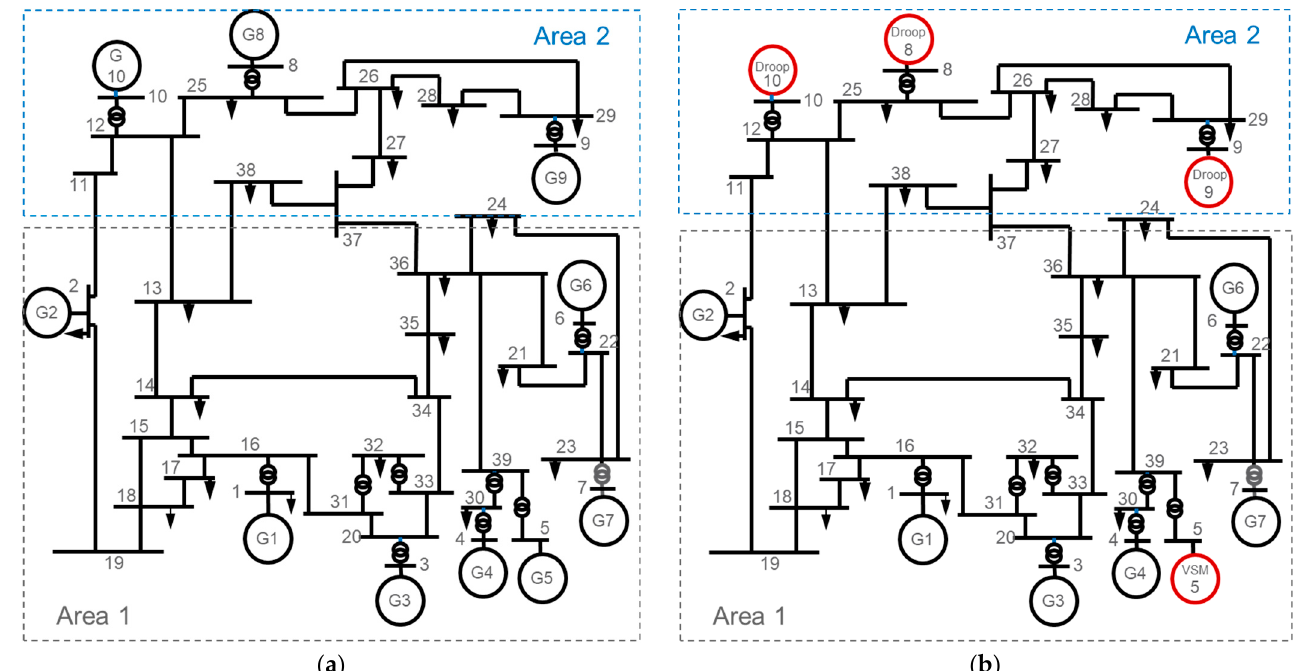
Figure 1. IEEE 39-bus New England test system. The base case system presented in ( a ) constitutes only synchoronous generators. The modified system in ( b ) includes converter-interfaced generation, placed at buses 5, 8, 9 and 10.